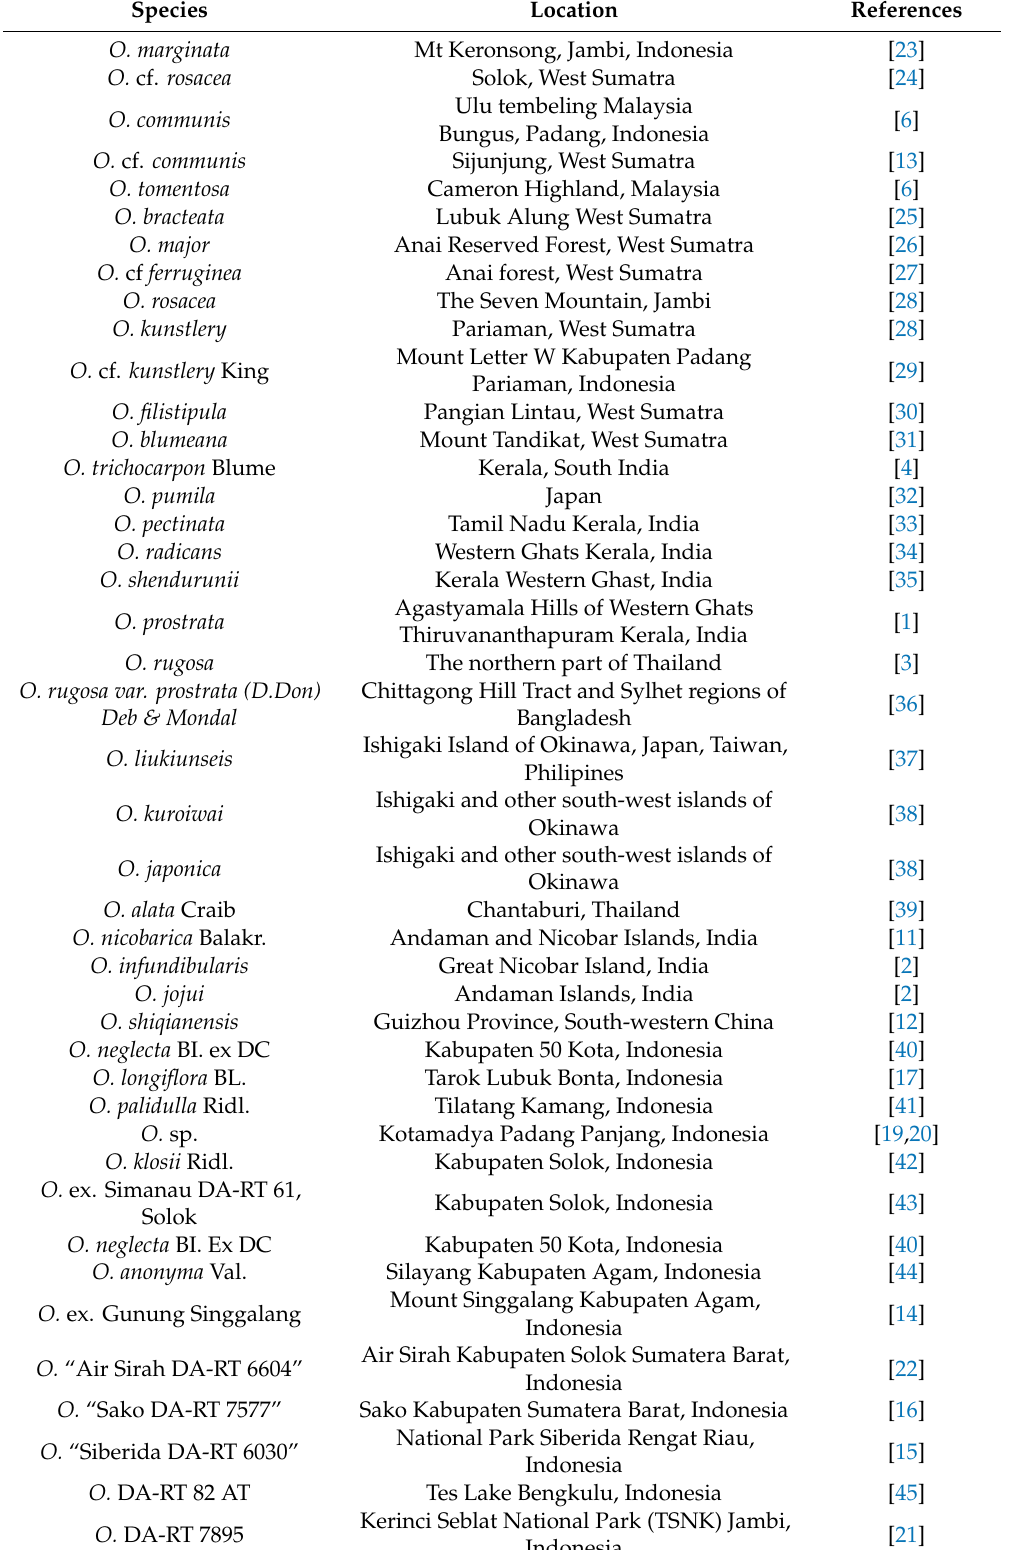
Table 1. Distribution of Ophiorrhiza species around the world.